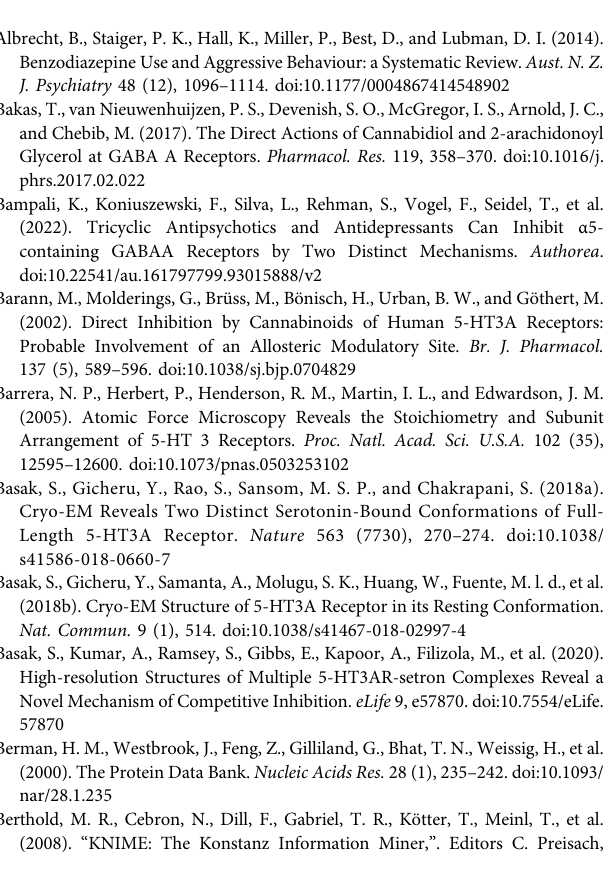
pink, 5OSC). The best scoring docking poses overlap only to a small extent with PS. Golden ribbon segments on TM3 and TM4 form ligand contacts. The